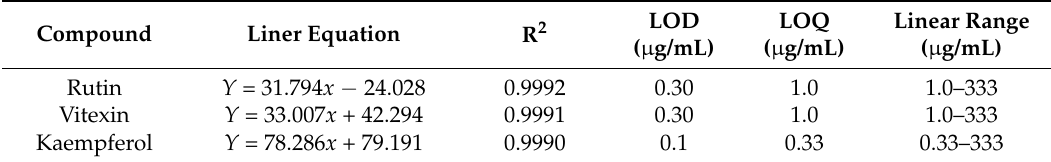
Table 2. Liner equation, correlation coefficients, limits of detection and limits of quantification of three